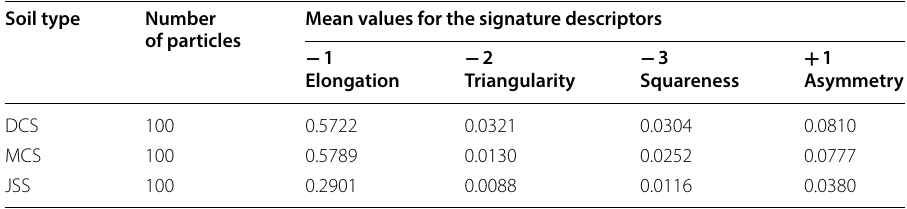
Table 1 General shapes used to investigate Fourier descriptors for morphological characterization, Mean values for the signature descriptors